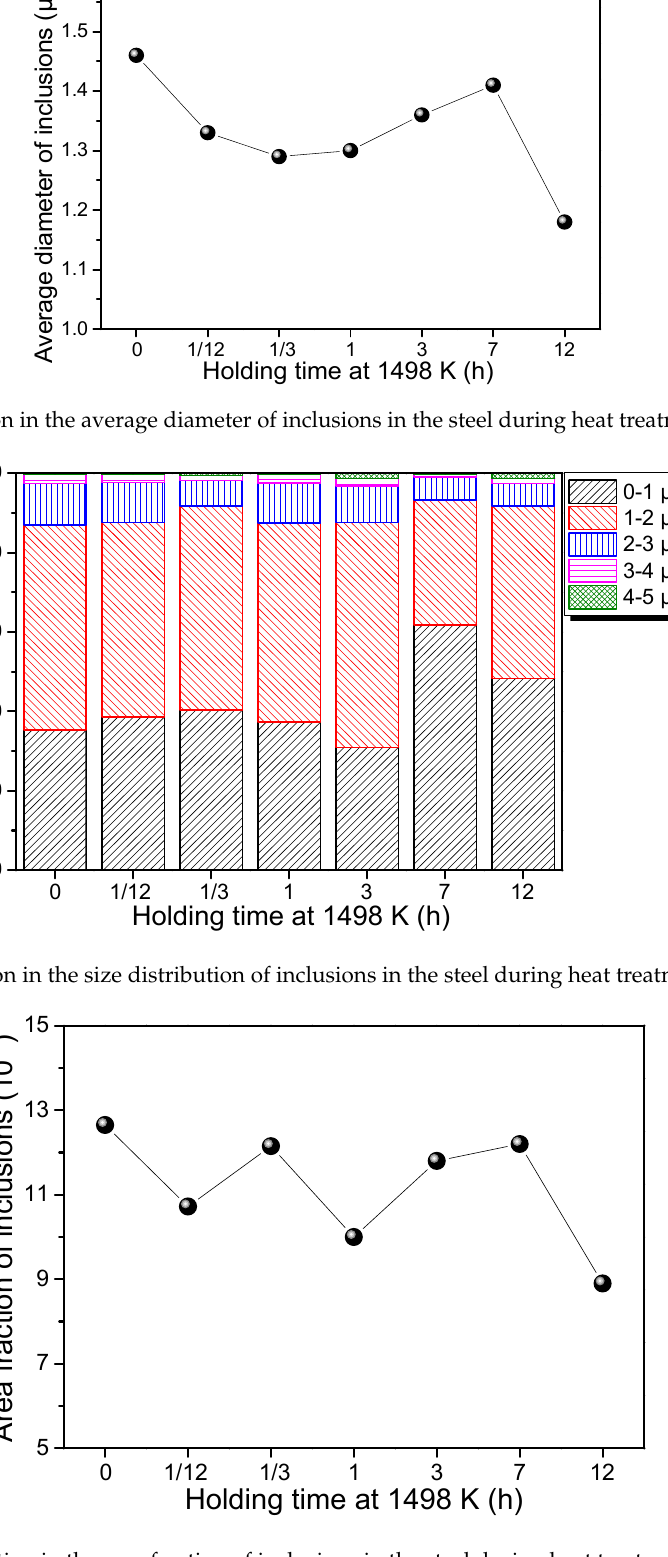
Figure 12. Variation in the area fraction of inclusions in the steel during heat treatment at 1498 K.